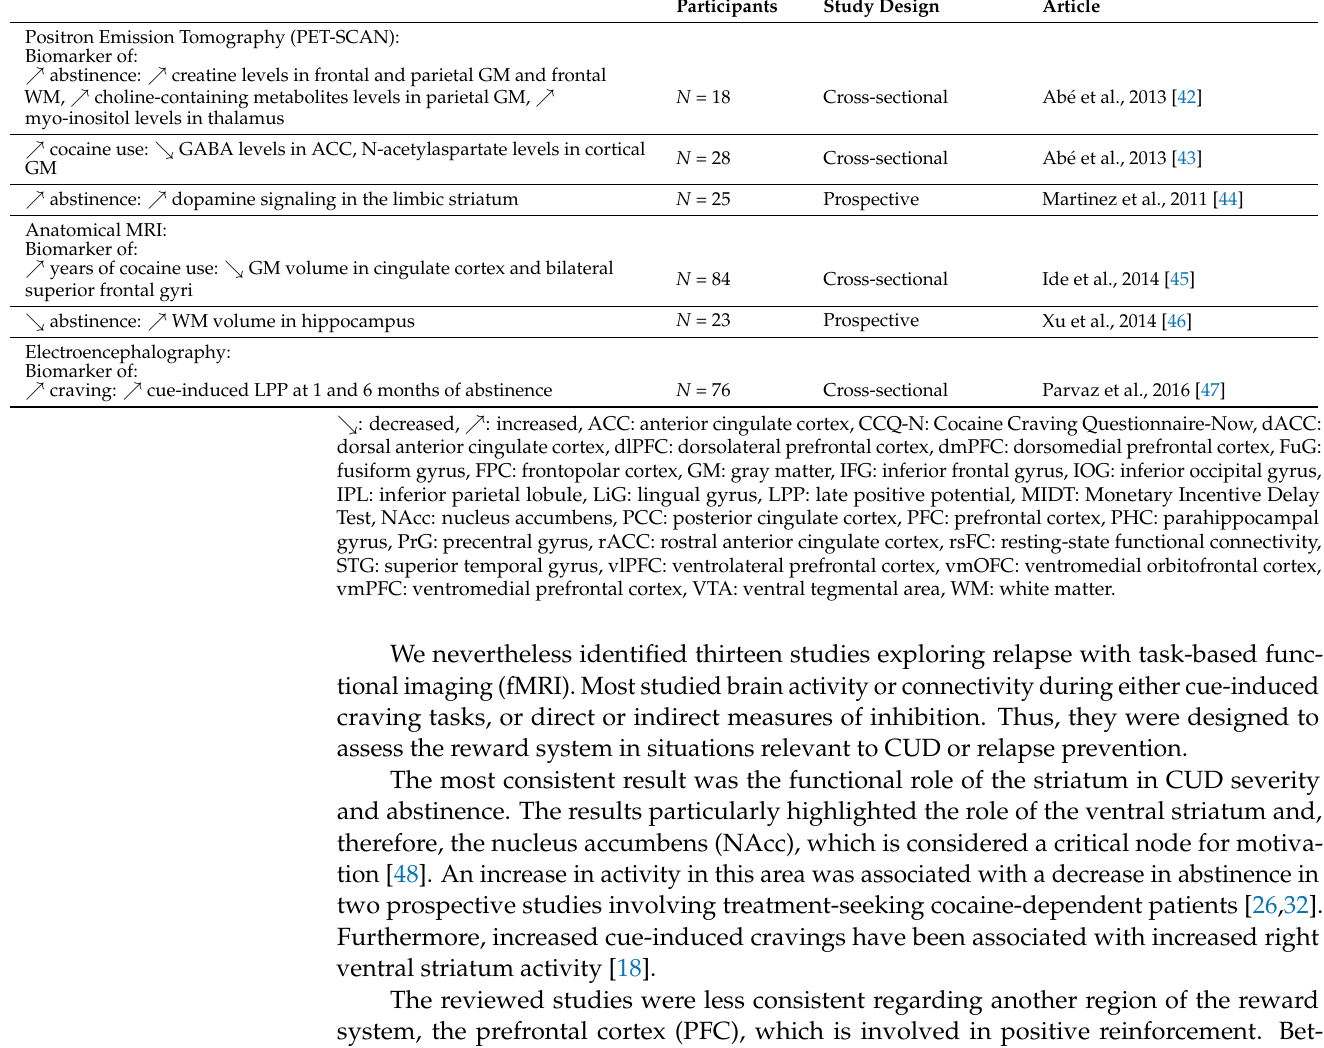
Participants Study